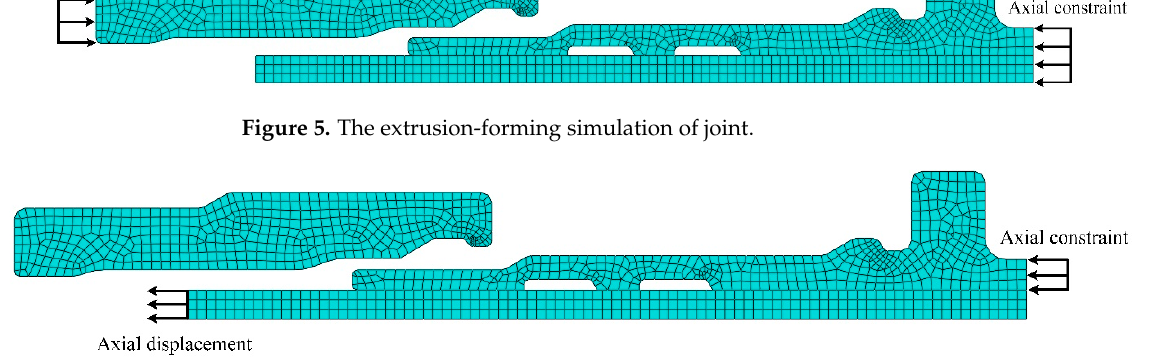
Figure 6. The simulation of tube pulling.